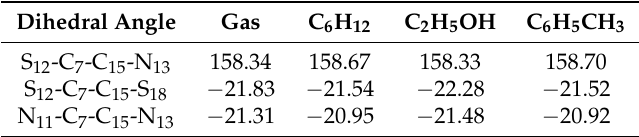
Table 1. Different dihedral angles (in degree) of native D-luciferin molecule, both in gas and solvent